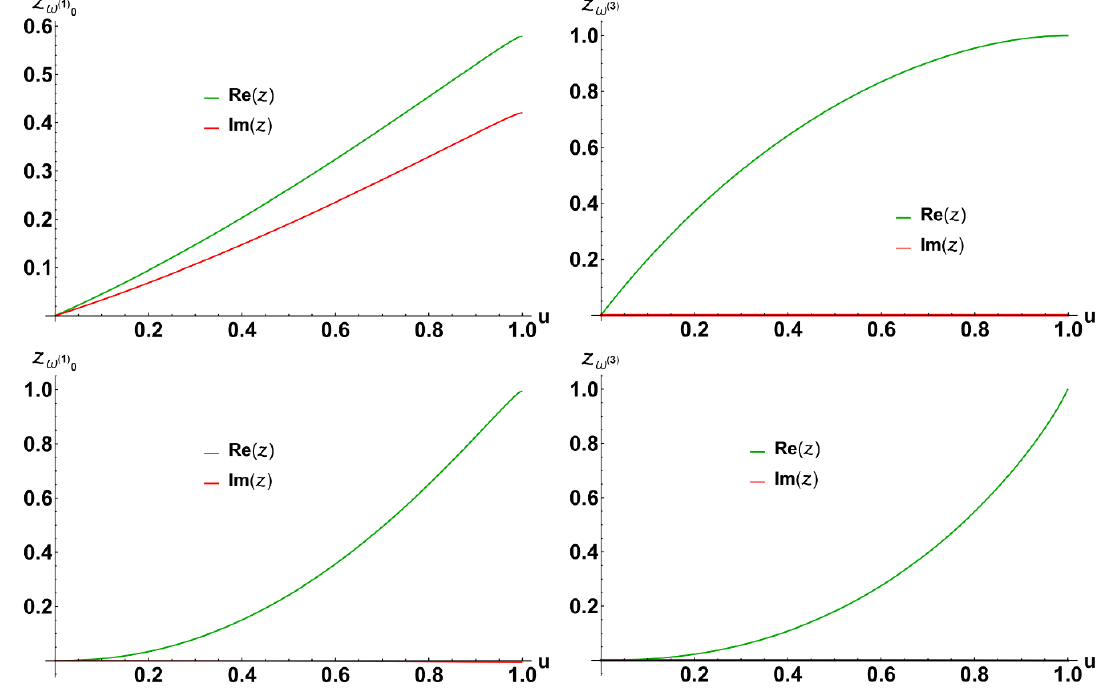
Figure 2 . The eigenmodes corresponding to the (cid:12)rst two QNMs with smallest absolute value of the frequencies at zero angular momentum are plotted for M = 0 : 5 (upper panels) and M = 1 : 1 lower panels. The left panels are the zeroth mode in the (cid:12)rst set and the right panels are the single mode in the third